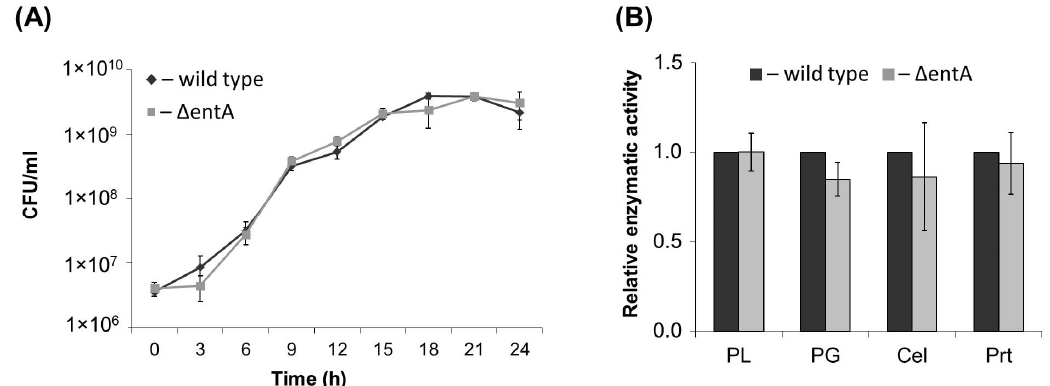
Figure 1. Growth curves ( A ) and activities of extracellular enzymes ( B ) of the wild type (dark grey) and ∆ entA mutant (light grey) of Pectobacterium atrosepticum SCRI1043. PL—pectate lyase, PG—polygalacturonase, Cel—cellulase, Prt—protease. The enzymatic activities were determined in the culture supernatants after one day of bacteria cultivation. The presented values are means ± SD of three biological replicates. The activity levels of the wild type were equated to one. No significant differences in the assessed parameters were revealed between the wild type and ∆ entA mutant (Mann-Whitney two-sided test, p < 0.05).